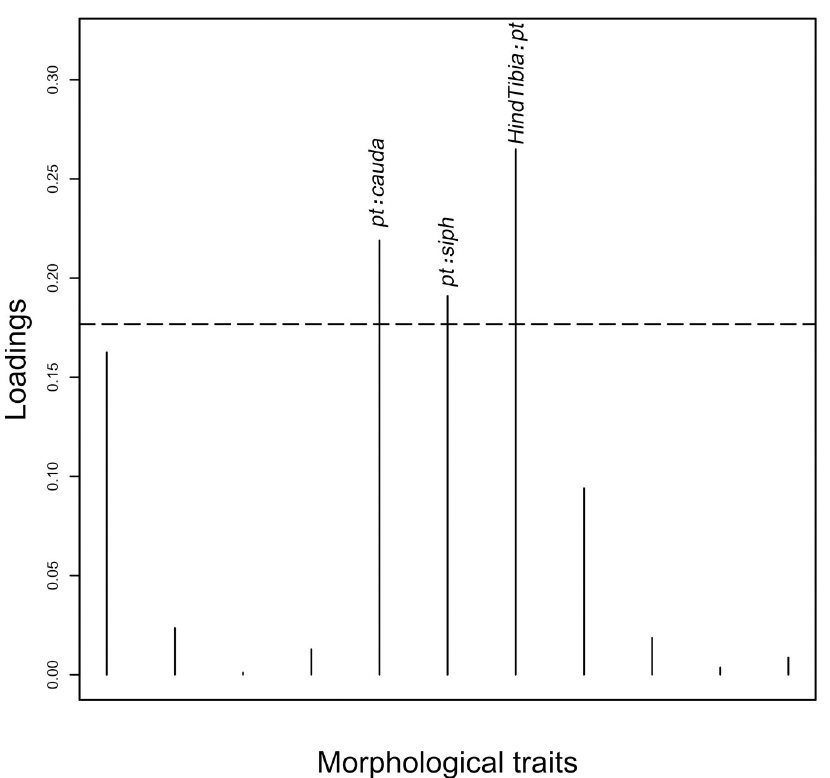
Fig 3. Canonical loading plot. The horizontal line is the limit showing the variables (morphological traits) that yield a cumulated 75% contribution to the DAPC. The individual peaks show the magnitude of the influence of each variable on separation of M . sorghi and M . sacchari .